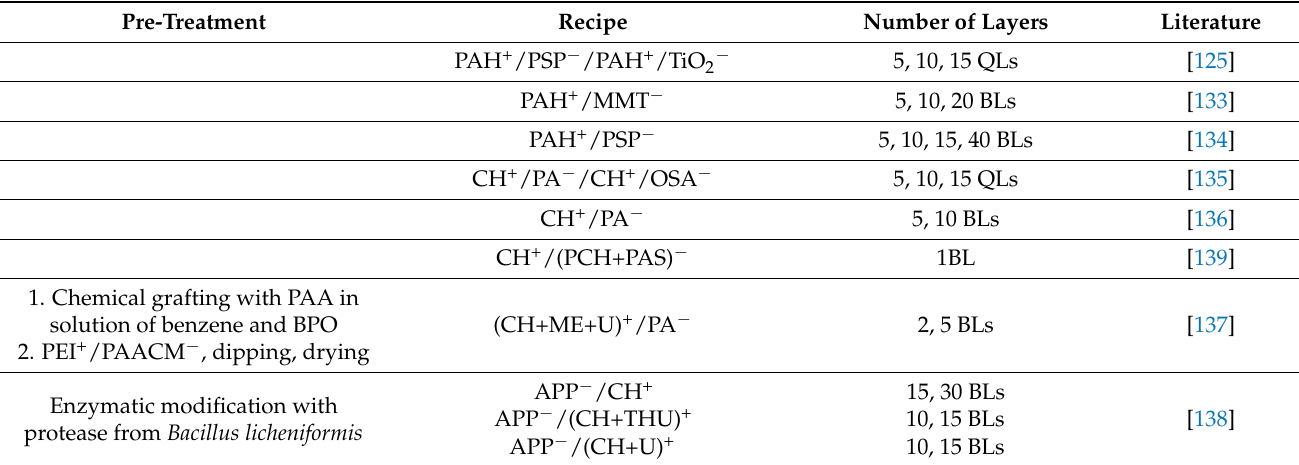
Figure 7. LbL deposition scheme of APP/CH+X on enzymatically modified PA6.6 fabric [138] Reproduced with permission from Jordanov, I.; Kolibaba, T.J.; Lazar, S.; Magovac, E.; Bischof, S.; Grunlan, J.C., J. Mater. Sci.; published by Springer Nature Switzerland AG., 2020. Table 4. Polyelectrolytes used to achieve FR of polyamide fabric.